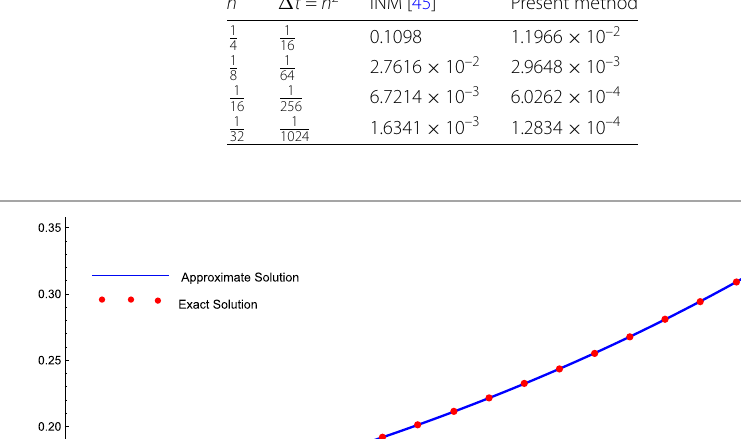
Table 5 Maximum absolute error ( L ∞ ) when α = 1.85 for Example 2 h (cid:11) t = h 2 INM [45] Present method